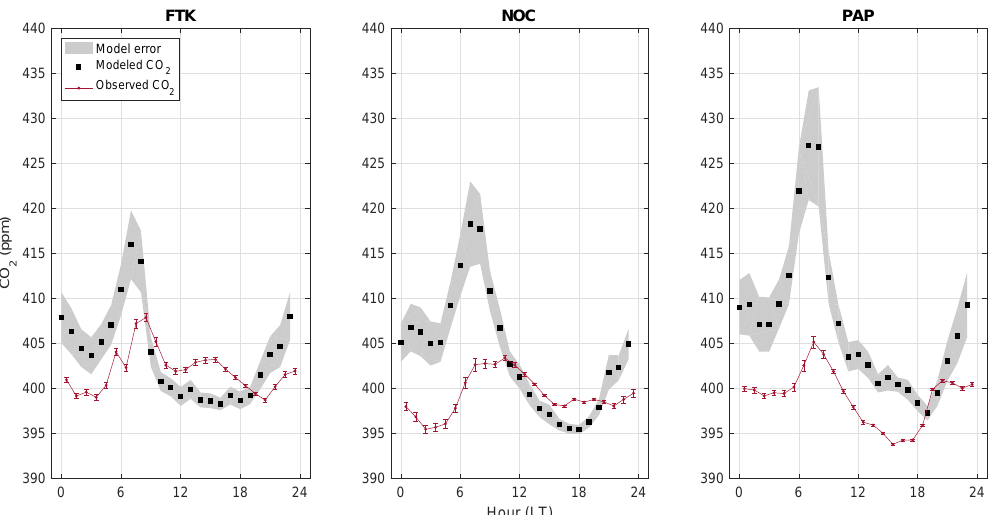
Figure 11. Diurnal variation in drift- and bias-corrected CO 2 dry air mole fractions observed and modeled at three representative BEACO 2 N sites during September 2013. Error bars indicate the standard error of the mean (instrument error is negligible at this timescale); thick shaded curves indicate standard deviation.